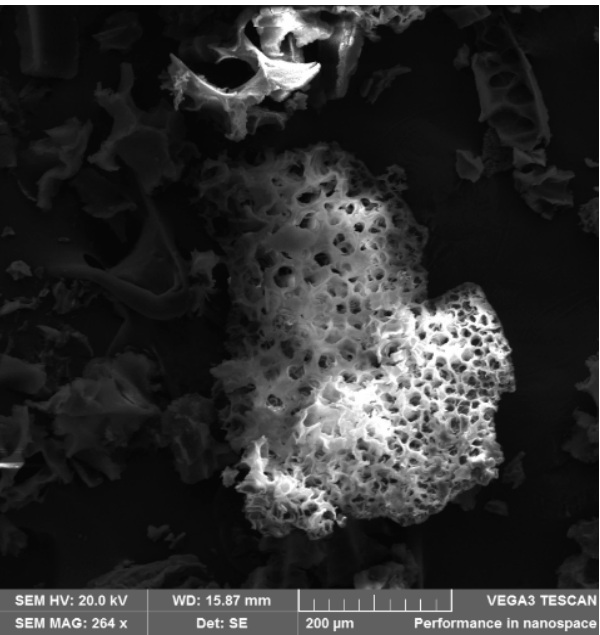
Figure 8. SEM image revealing the retained porosity of the crushed mesoporous composite polymer monolith.